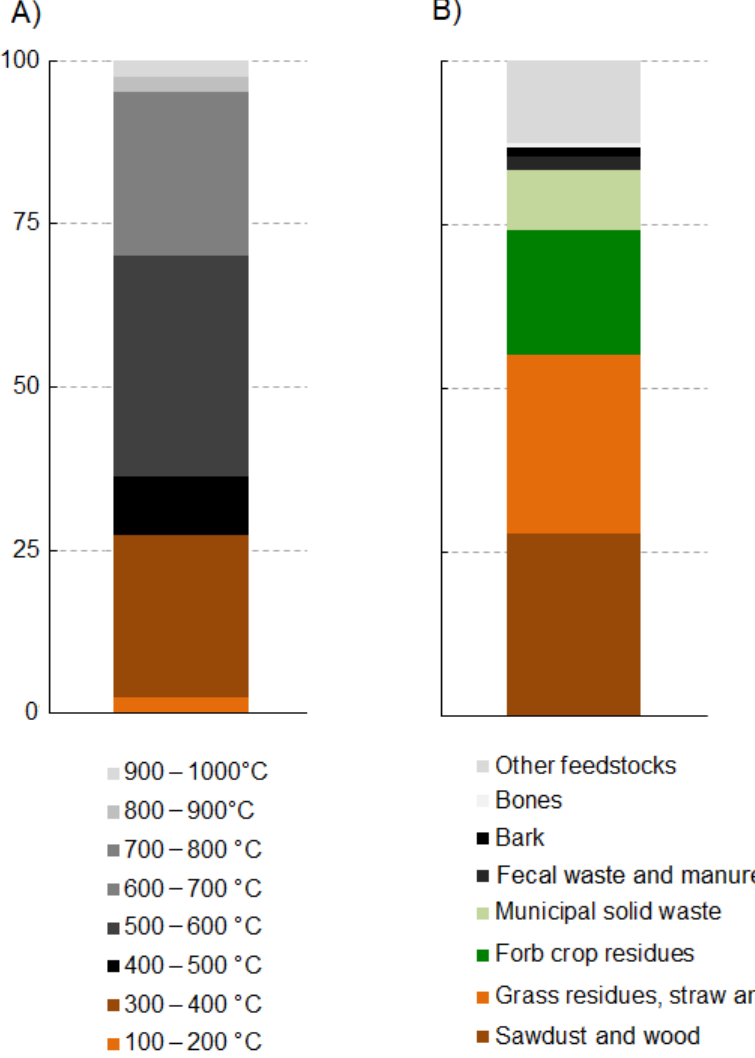
Figure 2. Stacked bar plots showing the relative frequencies of pyrolysis temperature ranges ( A ) and feedstock types ( B ) used in the collected research articles from the last seven years concerning the effects of biochar on plant disease suppression and pest control.